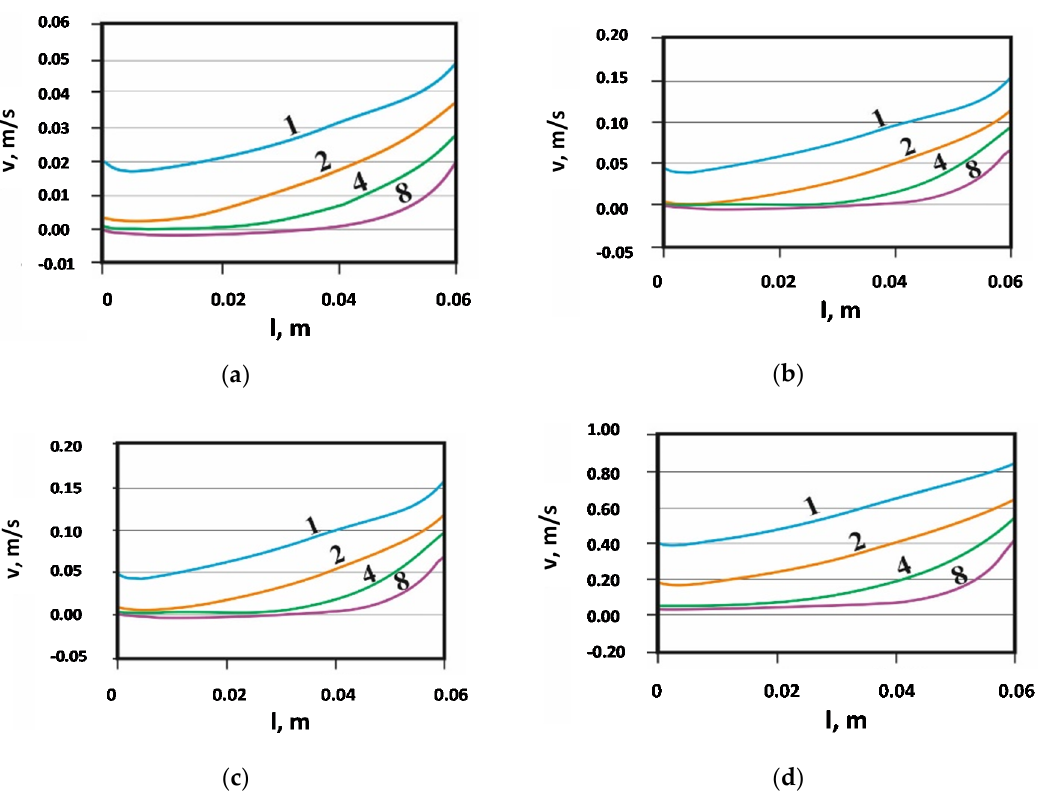
Figure 6. Distribution of metal flow velocity over the entire width of the catalyst (one, two, four and eight in the device channel) for different processing parameters: ( a ) current density 20 A, frequency 12,5 Hz; ( b ) current density 20 A, frequency 50 Hz; ( c ) current density 40 A, frequency 50 Hz; ( d ) current density 60 A, frequency 100 Hz.